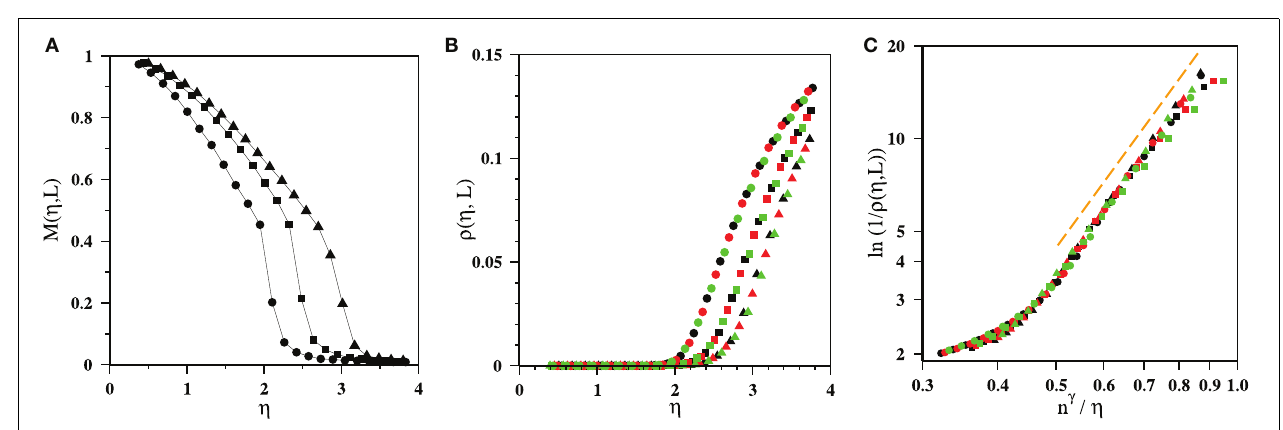
The vortex-pair density ρ ( η , L ) against η . (C) Scaling collapse of ln ( 1 / ρ ( η , L )) against n γ / η . For the collapse we use γ = 0 . 28. The dashed straight line, having slope α = 2 . 68, is a guide for the eye and indicates the power-law nature in the low noise